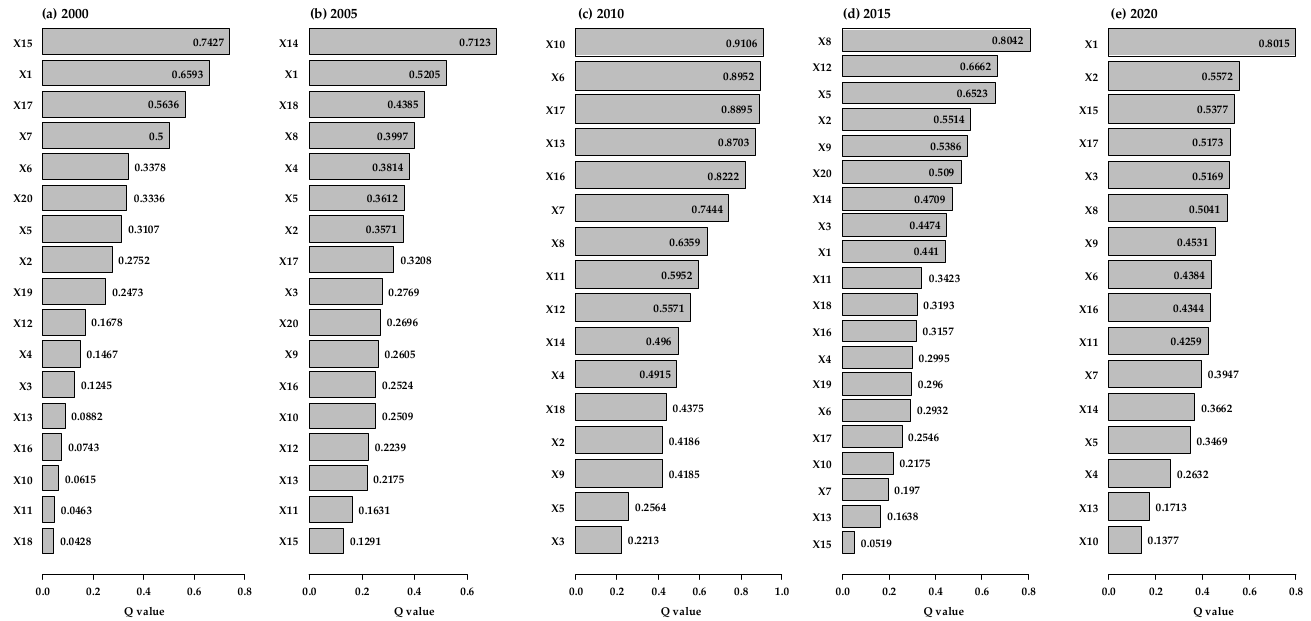
Figure 8. Contributions of variables to URID changes investigated by the factor detector from 2000 to 2020.